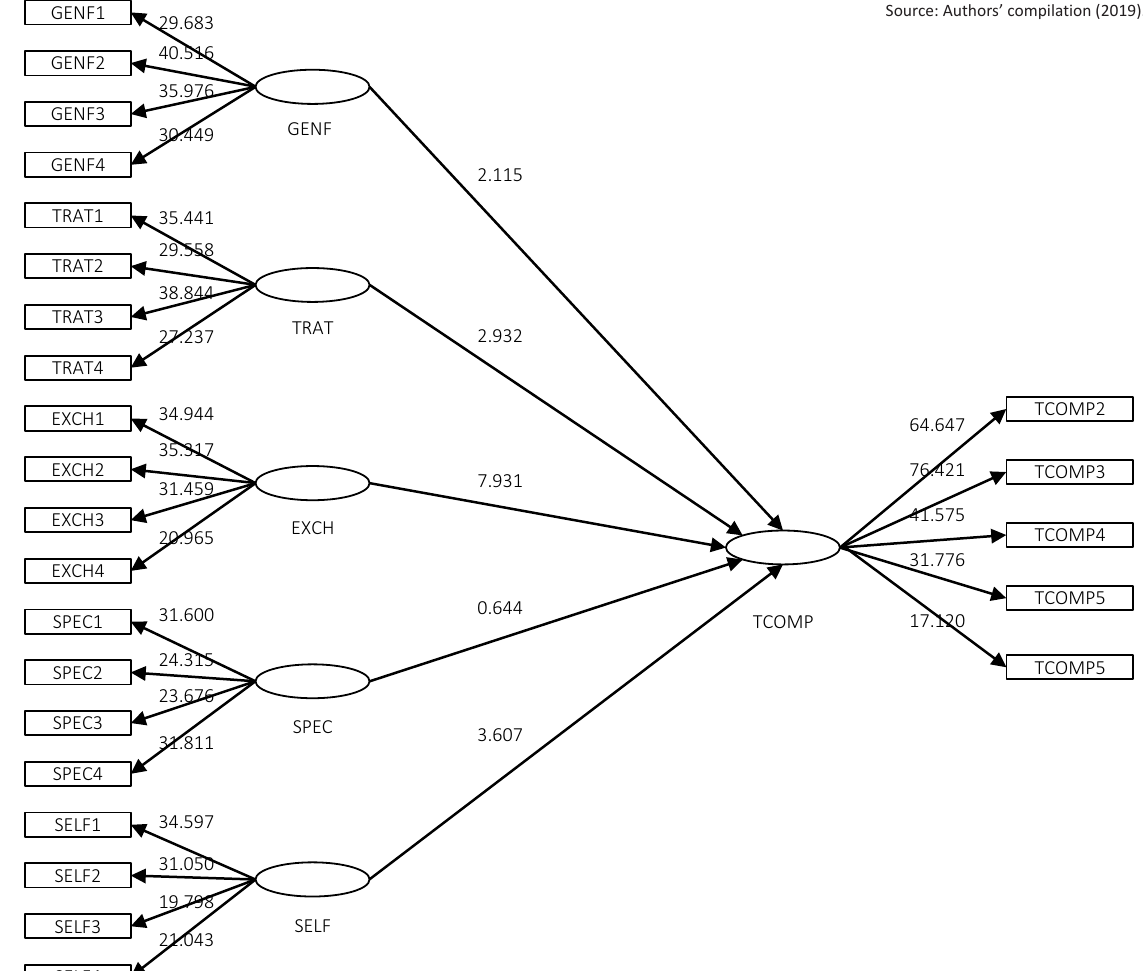
Figure 2. Structural